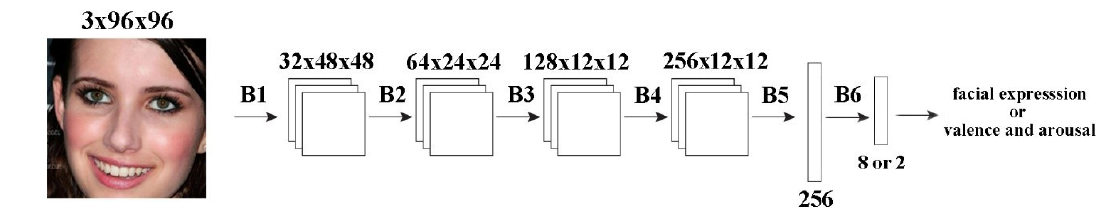
Figure 1. The architecture of our light-weight deep model for facial affective computing (the facial image is from the AffectNet [33]). The network consists of four convolutional blocks, where the raw image pixel is treated as the input.